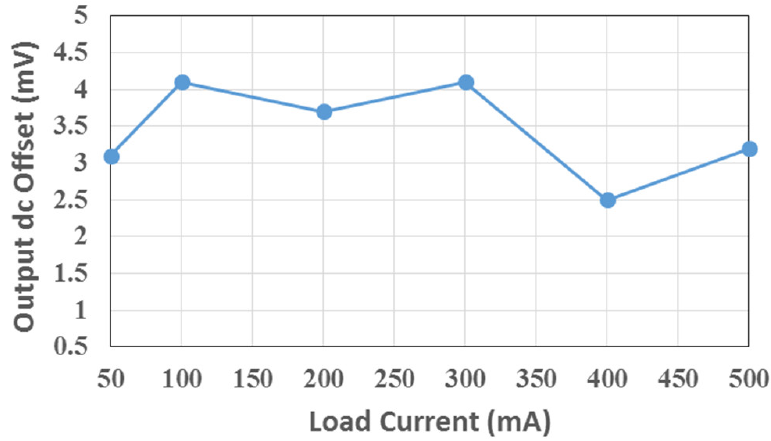
Figure 14. Output DC offset versus different load currents.